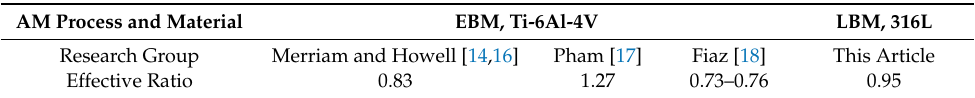
Table 2. Comparison of effective ratio of hinge thickness for metallic additive-manufactured leaf-type flexure hinges.